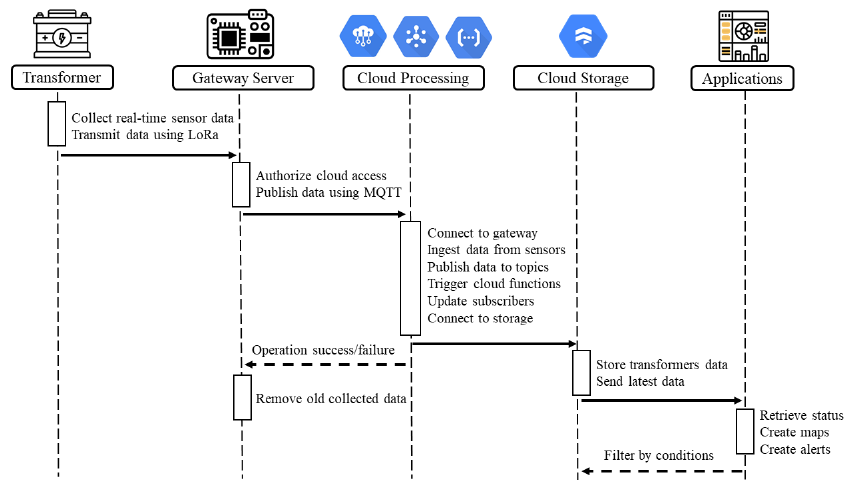
Figure 3. Sequence diagram of the system.